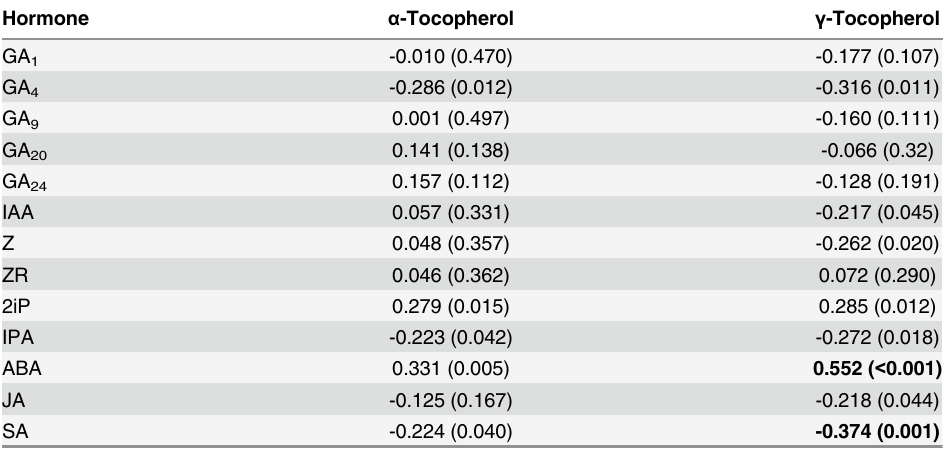
GAs, gibberellins; IAA, indole-3-acetic acid; Z, zeatin; ZR, zeatin riboside; 2iP, isopentenyl adenine; iPA, isopentenyl adenosine; SA, salicylic acid; JA, jasmonic